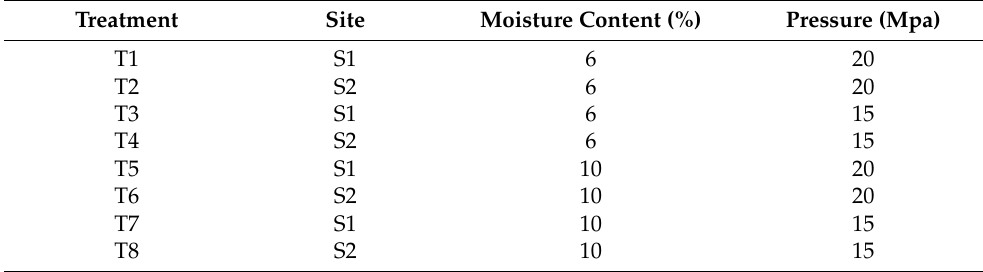
Table 1. Moisture conditions and pressure used in each treatment applied to the biomass used to produce briquettes.